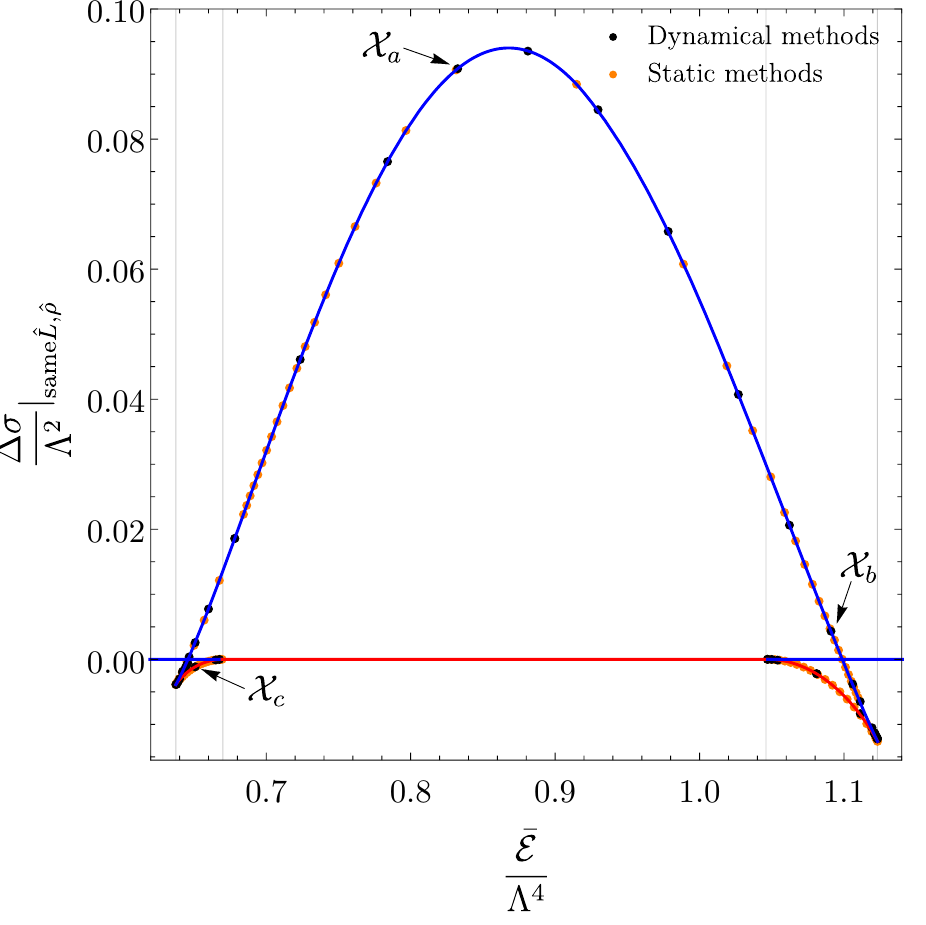
Figure 22 . Comparison of the entropy density of the static inhomogeneous solutions obtained with dynamical methods (black dots) and with static methods (orange dots) for a system with ˆ L ’ 11 . 501849 . Blue (red) curves indicate locally stable (unstable) solutions. Orange dots are exactly as in figure 17(bottom). Grey vertical lines indicate the location of the mergers and the cusps. The representative solutions X a , X b and X c have average energies ˆ and E ’ 0 . 651 ,